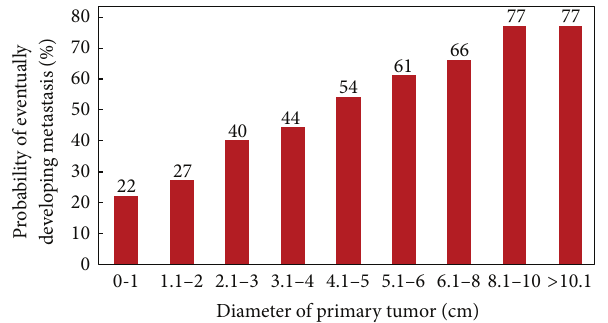
Figure 4: From Heimann and Hellman